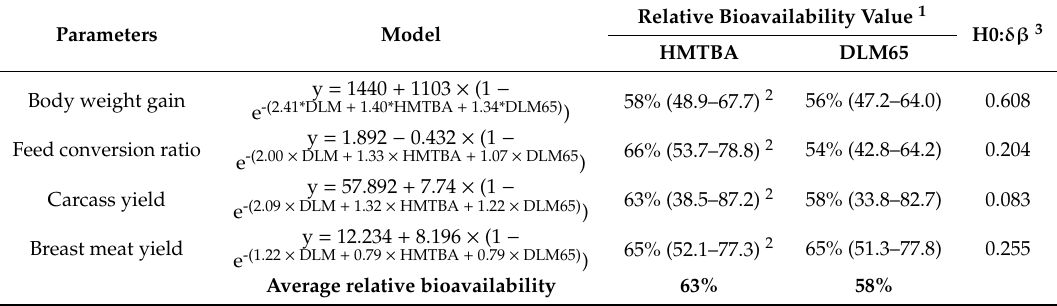
Table 5. Relative bioavailability values (RBV) of DL-2-hydroxy-4-methylthio butanoic acid (HMTBA) and 65% purity diluted DLM (DLM65) relative to DL-Methionine (DLM) for various performance criteria at day 35 determined by multi-exponential regression